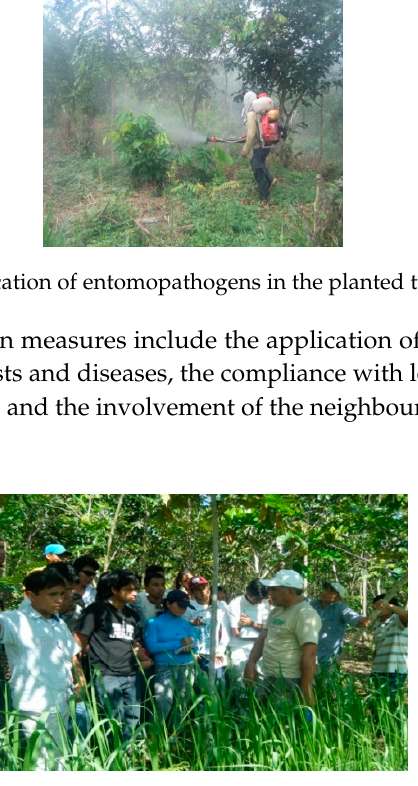
Figure 12. Pruning equipment to form crown.